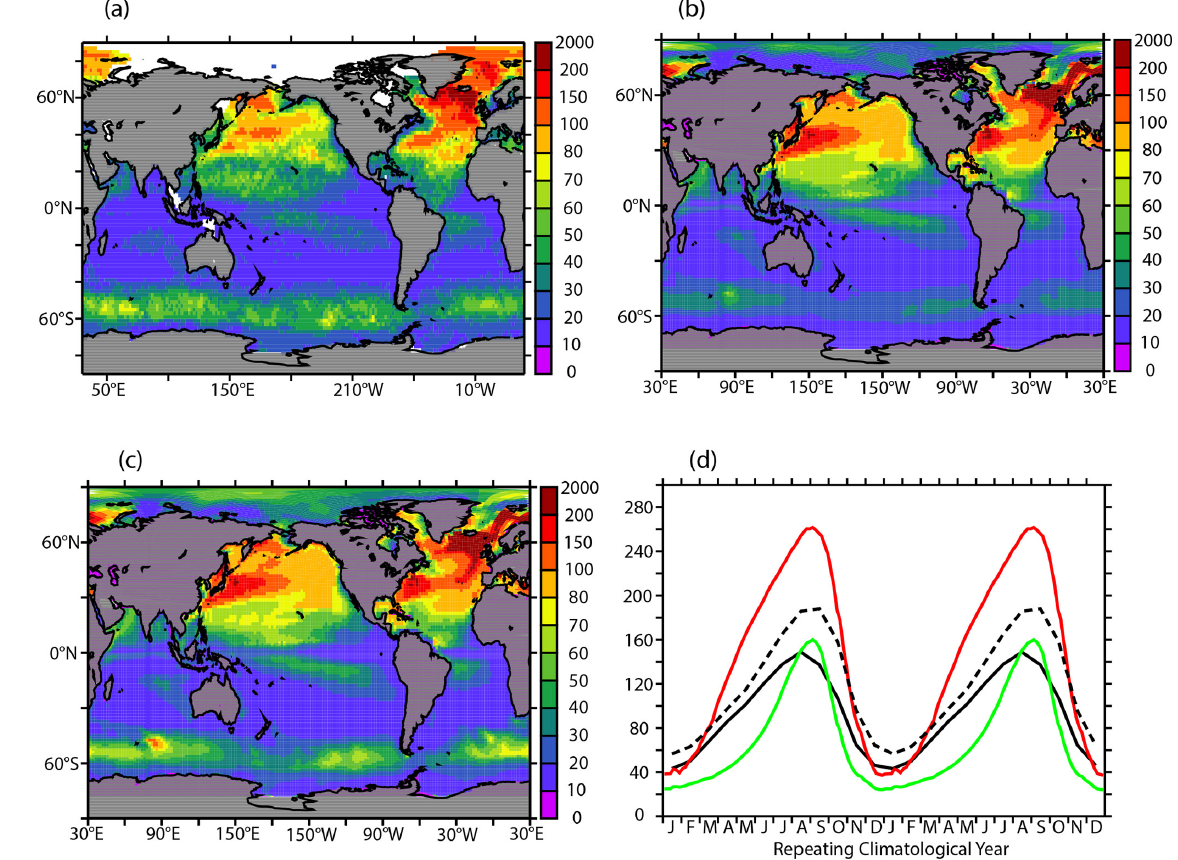
Figure 2. Mixed-layer depth (MLD) comparison; in all panels, units are meters. Updated product of de Boyer Montégut et al. (2004) averaged over austral summer (December-February, or DJF) using a 1σ 0 = 0 . 01 criterion (a) . CNTRL averaged over DJF for climatology constructed over 2000–2006 using a 1σ 0 = 0 . 01 criterion (b) . WSTIR averaged over DJF for climatology constructed over 2000–2006 using a 1σ 0 = 0 . 01 criterion (c) . Time series: evolution of MLD averaged over 50–60 ◦ S for data product of de Boyer Montégut et al. (2004) using a 1σ 0 = 0 . 01 criterion (solid black), 1σ 0 = 0 . 03 (dashed black), WSTIR (red), and CNTRL (green) (d)